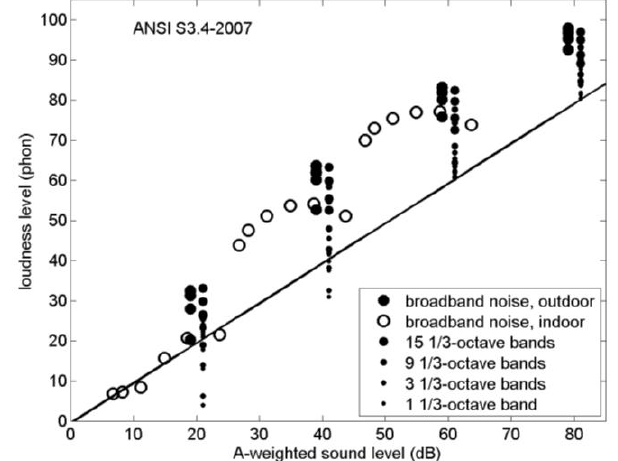
clarity, filled symbols have been shifted by +1dB or −1dB from 20, 40, 60, and 80 dB.